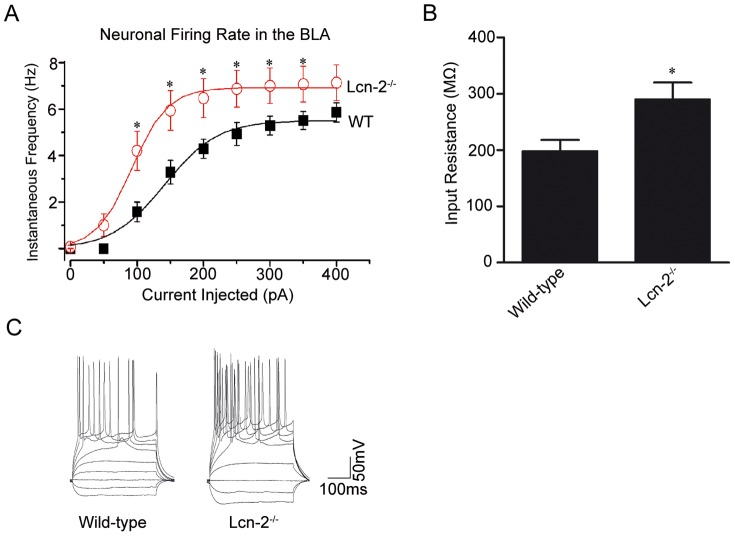
Region-specific control of neuronal excitability by lipocalin-2.Current-clamp experiments revealed that neuronal firing rate in the basolateral amygdala is higher in Lcn-2−/− mice when compared to Lcn-2+/+ animals. Voltage responses were recorded by current steps from −100 to +600 pA in 50 pA (starting membrane potential −80 mV) from principal neurons of the basal nucleus of the amygdala. Number of action potential spikes was counted as a function of depolarizing current injection (A). Disruption of the lipocalin-2 gene significantly increased action potential firing rate in Lcn-2−/− animals (p<0.01 at 150 pA; p<0.05 at 200 pA). Panel B shows a significant increase in the mean input resistance in Lcn-2−/− mice compared to wild-type animals. *p<0.05; Panel C is example of neuronal firing trace. Data are expressed as mean ± SEM.